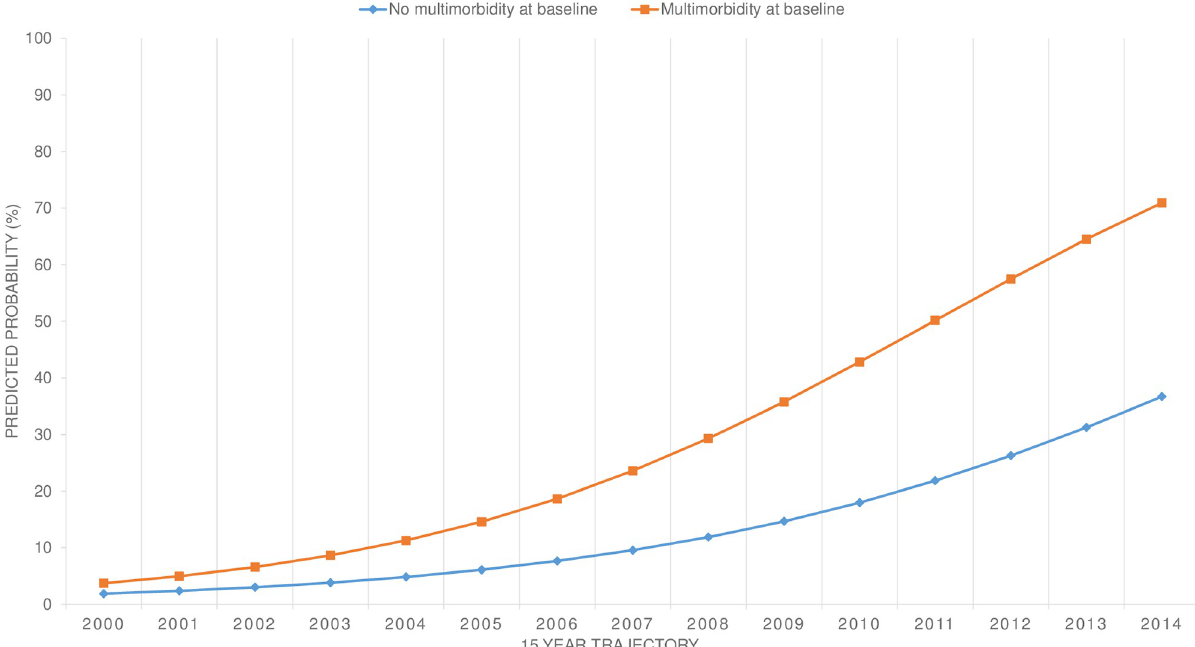
Fig 3. Predicted probability (cumulative) incident multimorbidity stratified according to medical history of multimorbidity at baseline.